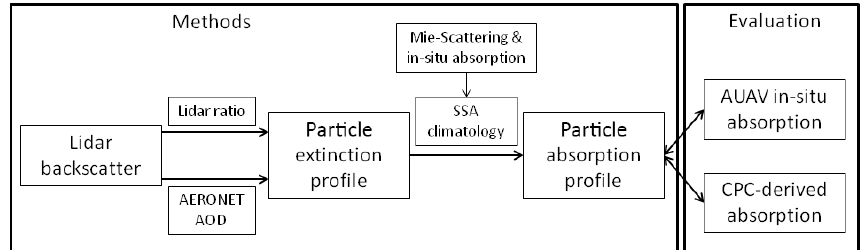
Figure 1. Flow chart describing the derivation of particle absorption profiles from lidar measurements, and their evaluation against in situ